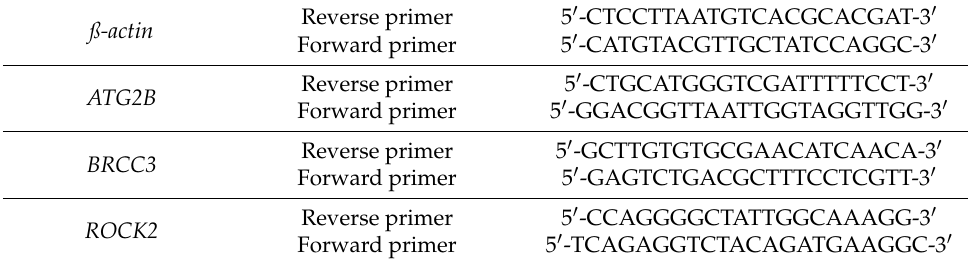
Table 1. Primers set used for